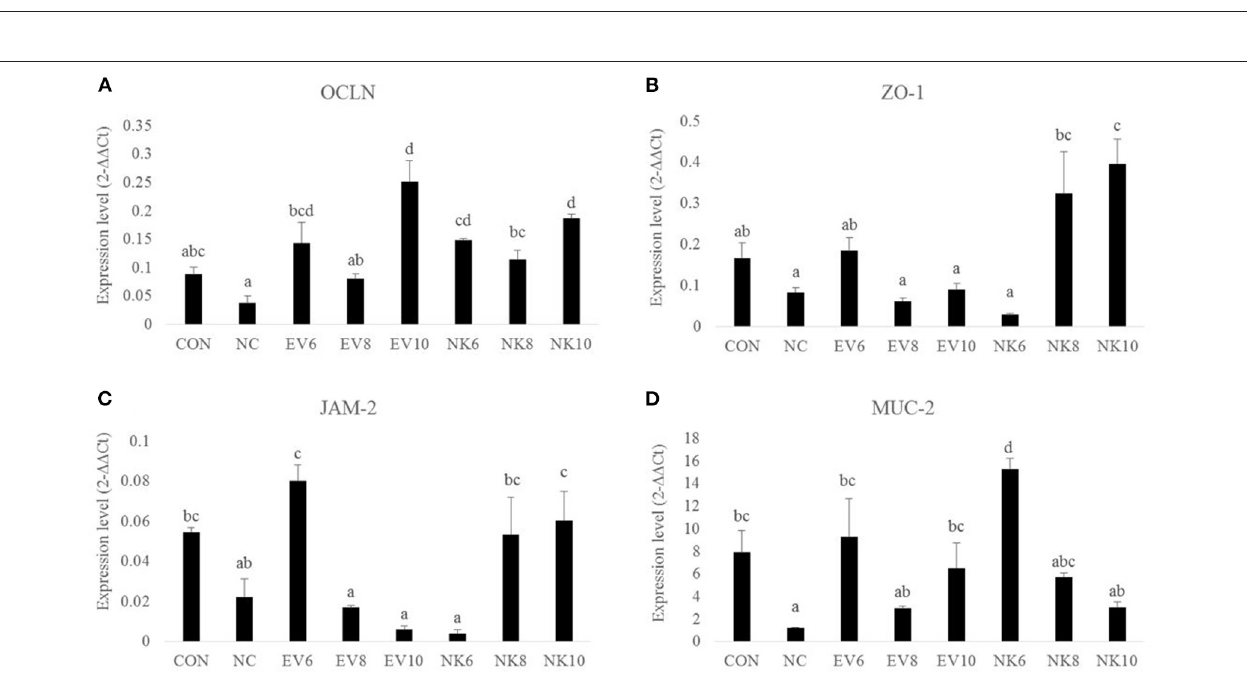
FIGURE 4 | Tight junction gene expression in duodenal mucosa of Eimeria acervulina -infected broiler chickens fed orally Bacillus subtilis expressing cNK-2 (13 dpi). All chickens except CON were infected by oral gavage at day 15 with 5,000 oocysts/chicken of E. acervulina . B. subtilis was administrated by oral gavage at days 14–16. EV, B. subtilis (empty vector), NK, B. subtilis- cNK-2; NC, E. acervulina infected non- B. subtilis control; EV6, B. subtilis- EV at 10 6 cfu/day; EV8, B. subtilis- EV at 10 8 cfu/day; EV10, B. subtilis- EV at 10 10 cfu/day; NK6, B. subtilis- cNK-2 at 10 6 cfu/day; NK8, B. subtilis- cNK-2 at 10 8 cfu/day; NK10, B. subtilis- cNK-2 at 10 10 cfu/day. Transcript levels of (A) occludin (OCLN), (B) zonula occludens-1 (ZO1), (C) junctional adhesion molecule 2 (JAM2), and (D) Mucin-2 (MUC-2) in duodenal mucosa were measured by quantitative RT-PCR and genes expression were analyzed using the 2 − 11 Ct method. a − d Bars with no common letter differ significantly ( p < 0.05). Each bar represents the mean ± SEM ( n =